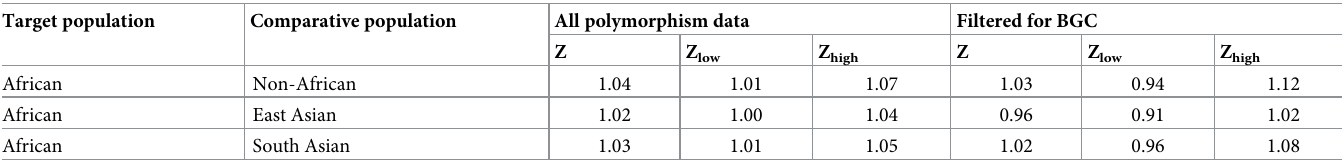
Table 3. Testing for the effects of biased gene conversion II. The values of Z when only G <> C and A <> T mutations are considered. Code to extract and analyse the data can be found at https://github.com/vivaksoni/test_for_balancing_selection. Target